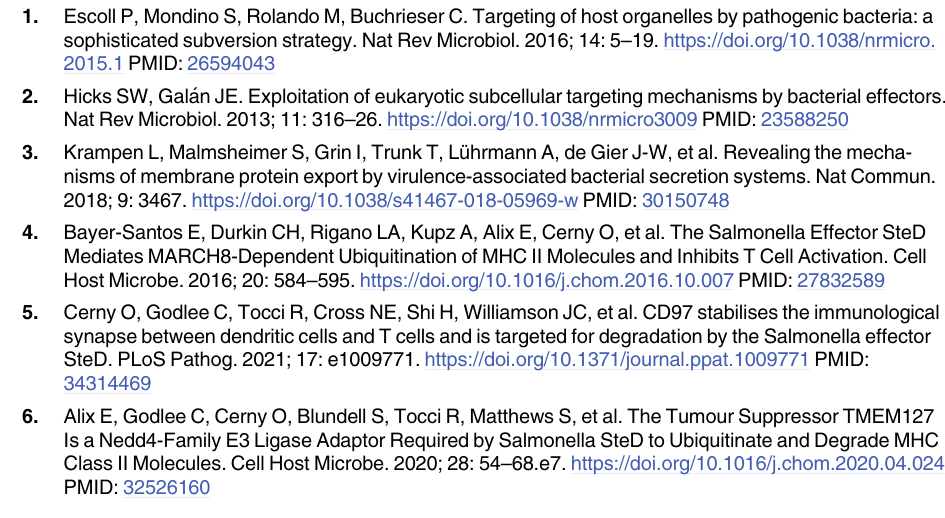
S1 Table. S . Typhimurium strains used in this study. S2 Table. Plasmids used in this study. (PDF) S3 Table. Primary antibodies used in this study. (PDF) S4 Table. Primers used in this